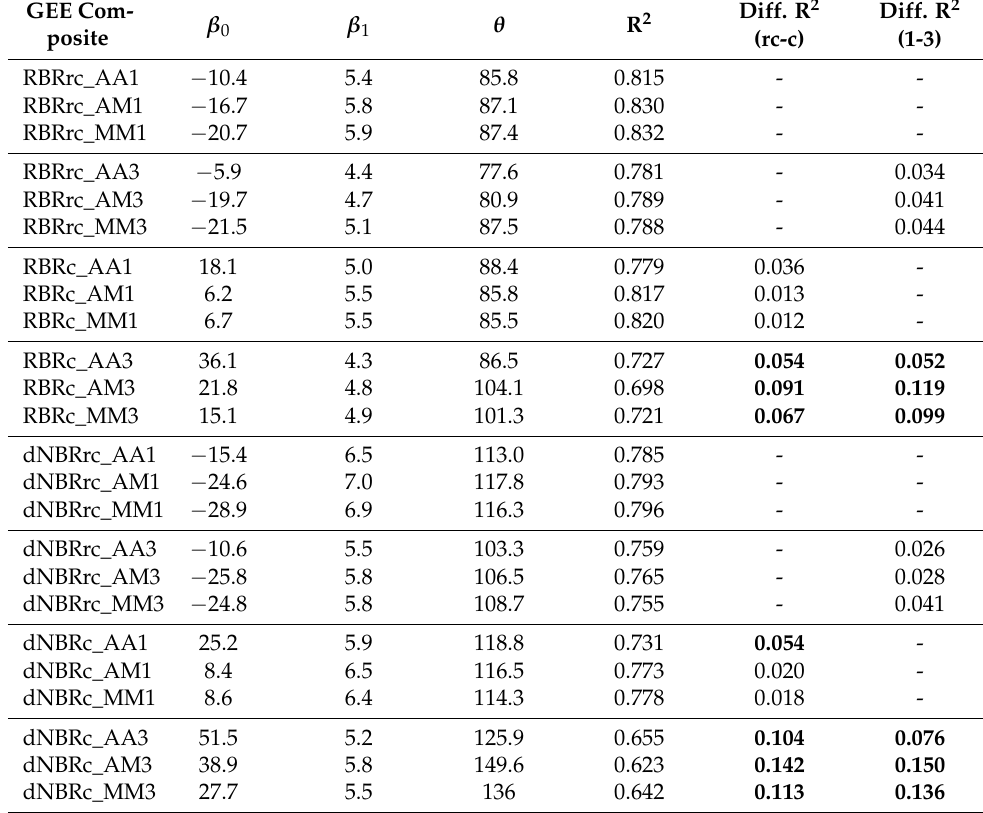
Table 5. Goodness of fit and coefficients of linear models between spectral indices from composite images and the field-based severity index FSI 2 for the three wildfires of Durango.